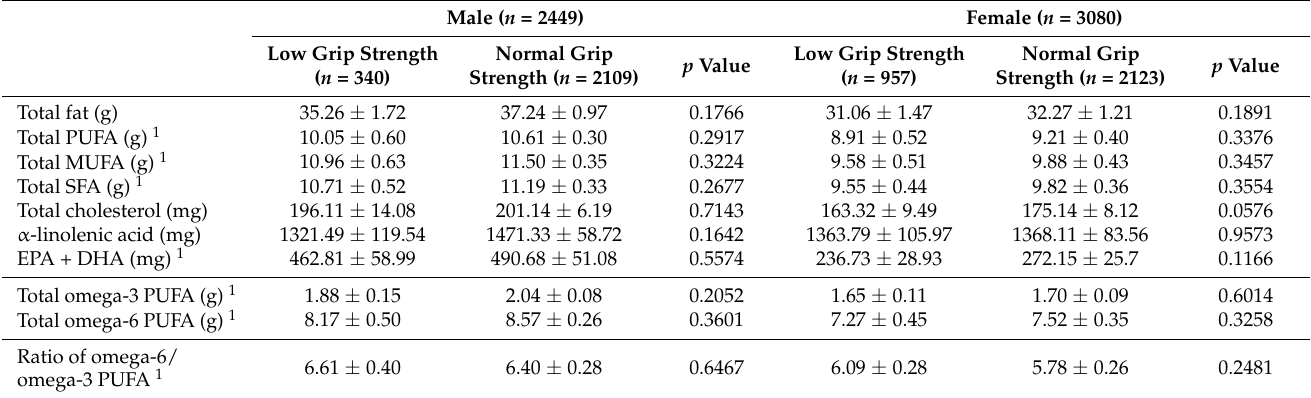
Table 3. Fat intakes of the study subjects according to grip